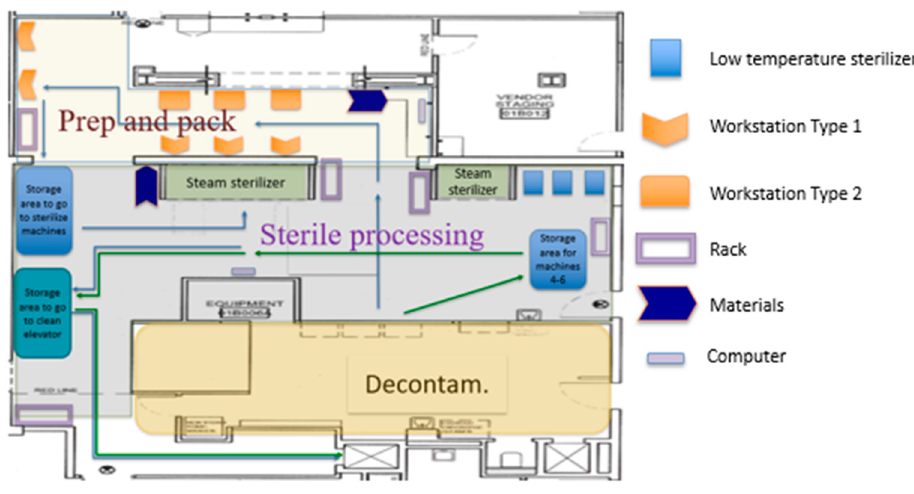
Figure 10. Separation of activities by phase on SPD. Proposed layout #1.